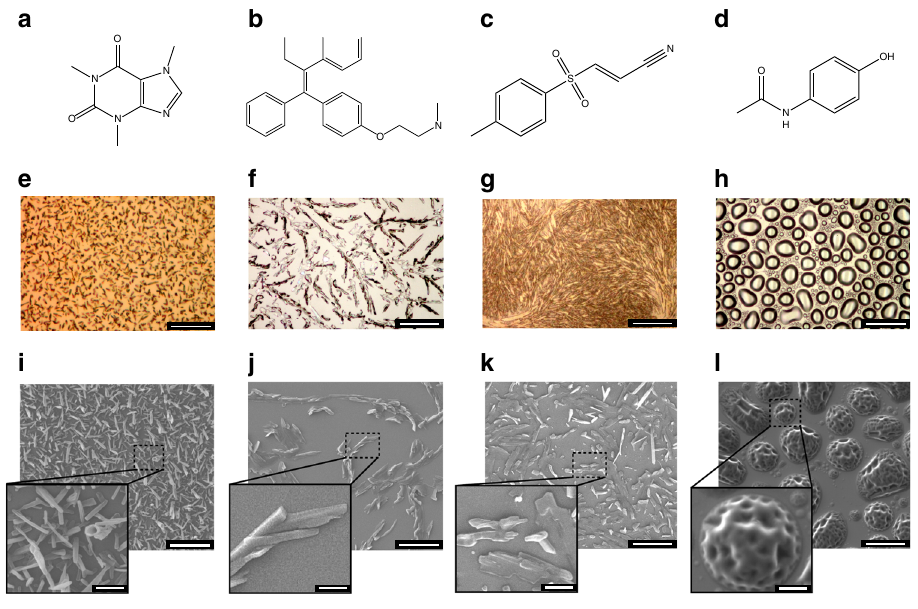
Fig. 3 Chemical formulae of compounds used in this study, along with optical ( color ) and electron ( gray-scale ) micrographs of resulting fi lms. (a, e, i) Caffeine, (b, f, j) Tamoxifen, (c, g, k) BAY 11-7082, (d, h, l) Paracetamol. The scale bar in (i, j, k, l) is 10 μ m, with the inset scale bar 2 μ